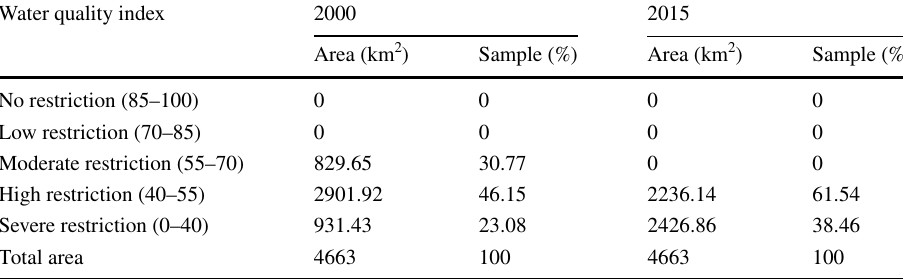
Table 5 Irrigation water